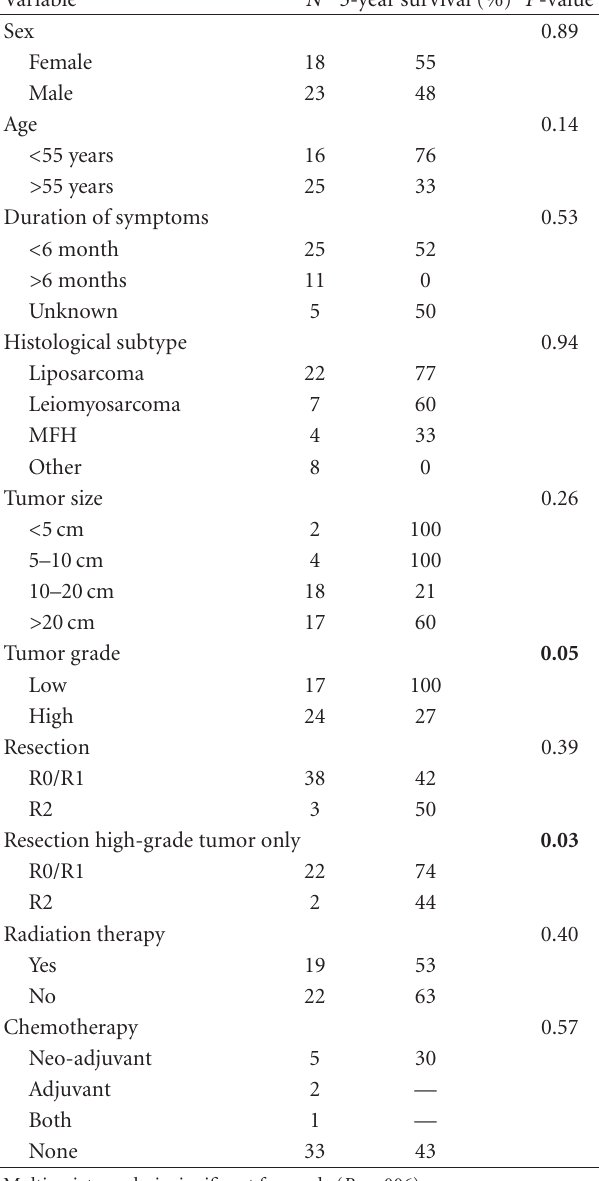
Table 3: Univariate analysis of prognostic factors for overall survival in 41 patients with primary retroperitoneal